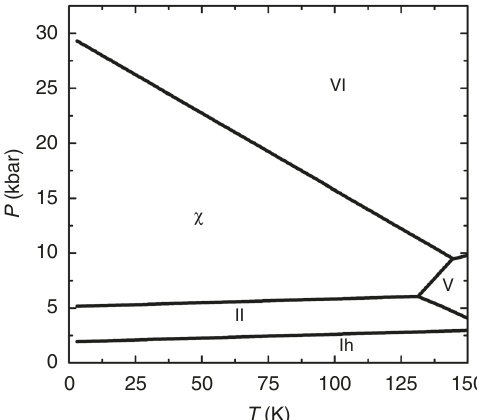
Fig. 5 Phase diagram for TIP4P/2005 water model. The T – P phase diagram for TIP4P/2005 water model, obtained from free-energy rection. Figure 4 depicts the relative enthalpy (with ice VI being the reference) vs. pressure for ice XI, ice II, ice χ , ice B, and polar ice B. The point at which two curves cross marks the transition pressure between the two corresponding phases at 0 K. At